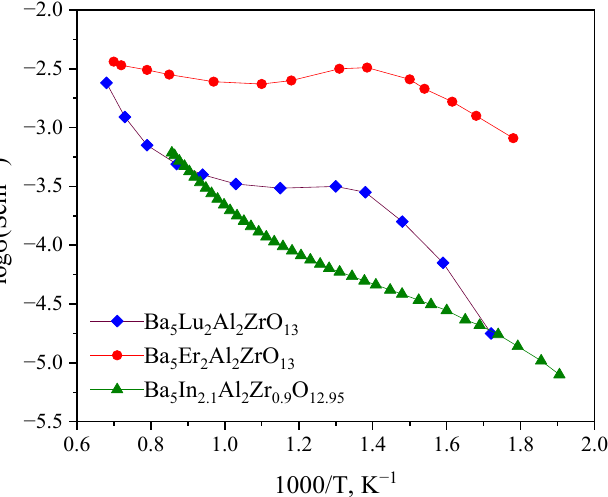
Figure 15. Temperature dependencies of total conductivity in wet air ( p H 2 O = 1.92 · 10 − 2 atm) for Ba 5 Er 2 Al 2 ZrO 13 [40], Ba 5 Lu 2 Al 2 ZrO 13 [40] and Ba 5 In 2.1 Al 2 Zr 0.9 O 12.95 .